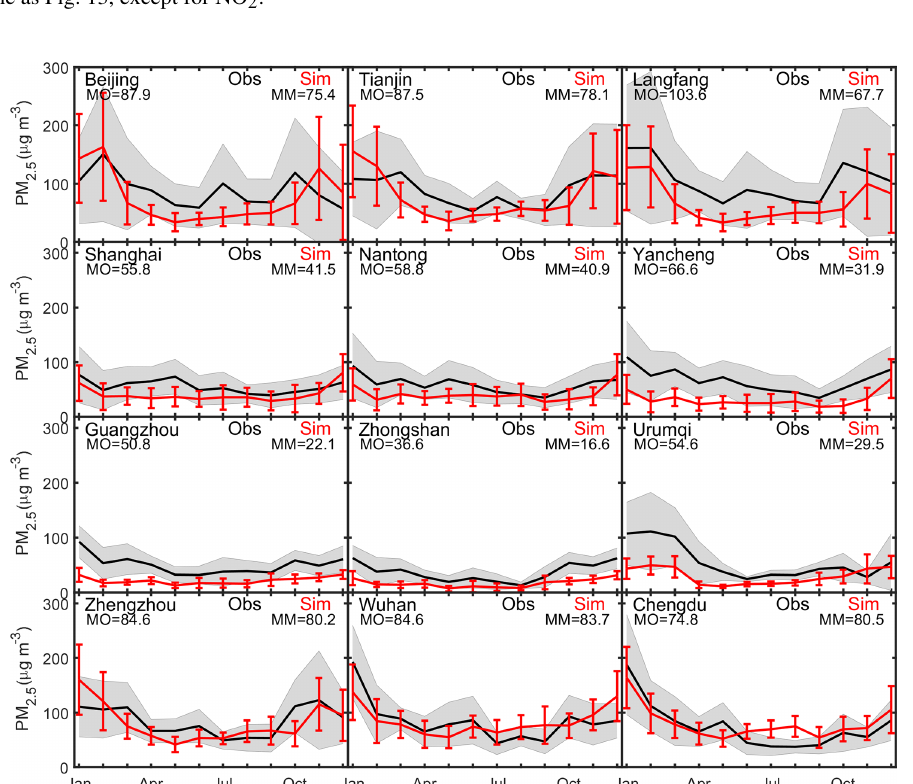
Figure 15. The same as Fig. 13 components of PM 2 . 5 include primary PM 2 . 5 , BC, POA, SOA, and SNA.